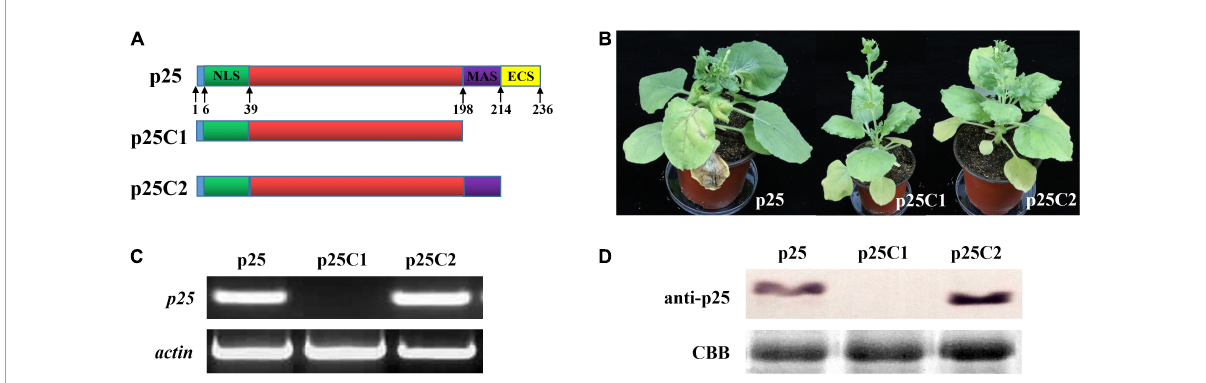
FIGURE5 Functional analysis of the C-terminal region of p25. (A) The fused protein constructs. p25, plant inoculated with hybrid virus TMV-p25;. p25C1, plant inoculated with hybrid virus TMV-p25C1; p25C2, plant inoculated with hybrid virus TMV-p25C2. (B) Phenotype of Nicotiana benthamiana plants after inoculation with hybrid virus TMV-p25, TMV-p25C1, or TMV-p25C2. (C) The transcriptional level was detected by RT-PCR using extracted leaf RNA after reverse transcription. N. benthamiana actin was used as the internal control. (D) Western blot of p25 using anti-p25